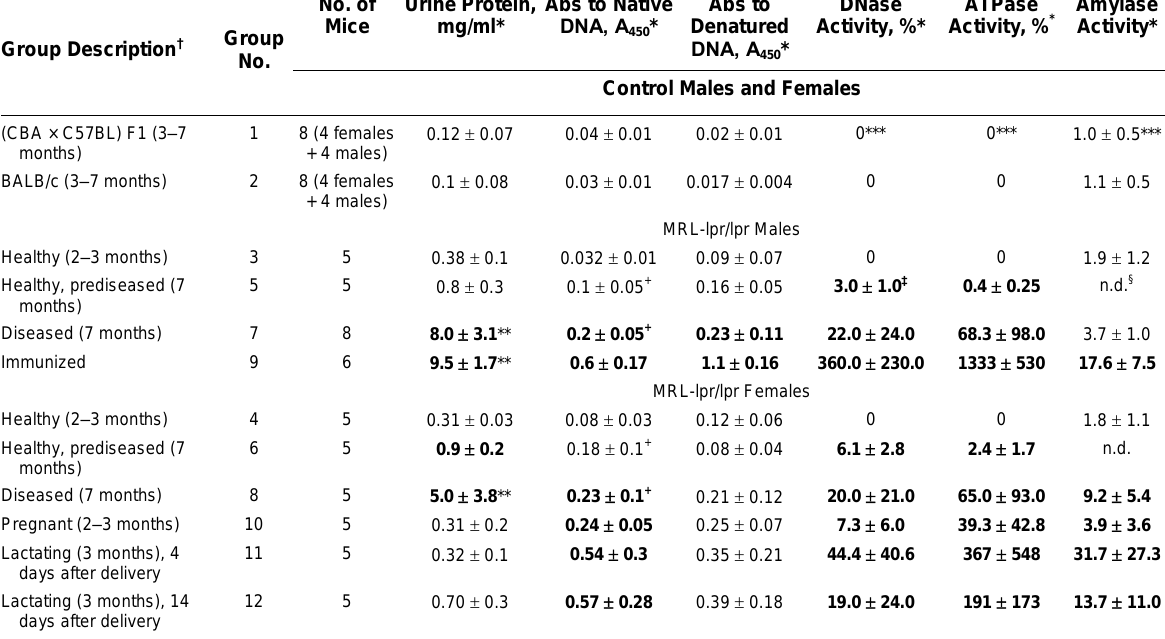
Autoimmune Characteristics of Autoimmune-Prone MRL-lpr/lpr and Control